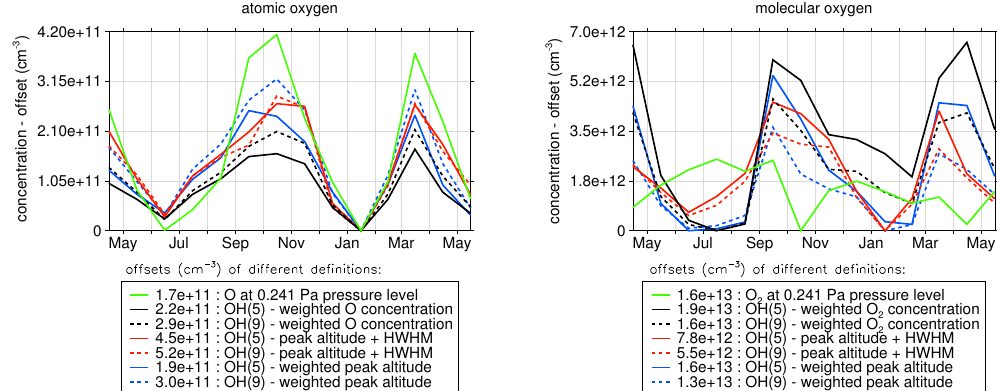
Figure 3. Seasonal variability of simulated atomic and molecular oxygen concentrations from April 2010 to June 2011 according to the following definitions: O concentration at fixed pressure level (green line), O concentration interpolated at +HWHM-shifted and weighted peak altitudes (red and blue lines), O concentration weighted with OH concentrations (black lines). From each curve the offsets listed in the legend were subtracted to allow a better intercomparison of the temporal changes.